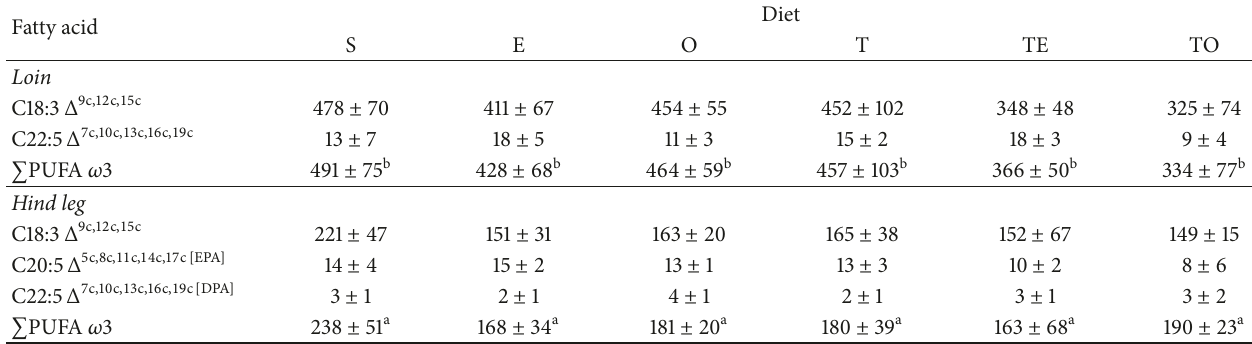
Table 6: PUFA 𝜔 3 content (mg/100g meat) in rabbit loin and hind leg muscle.